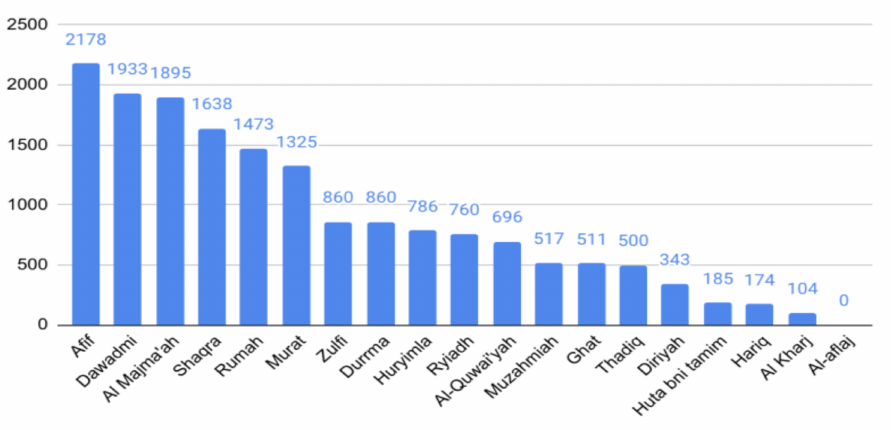
Figure 11. Distribution of sites with a suitability factor greater than 80% in the cities. Table 12. Scoring of regions with a suitability degree greater than 80%. Cities Area (Km 2 ) %